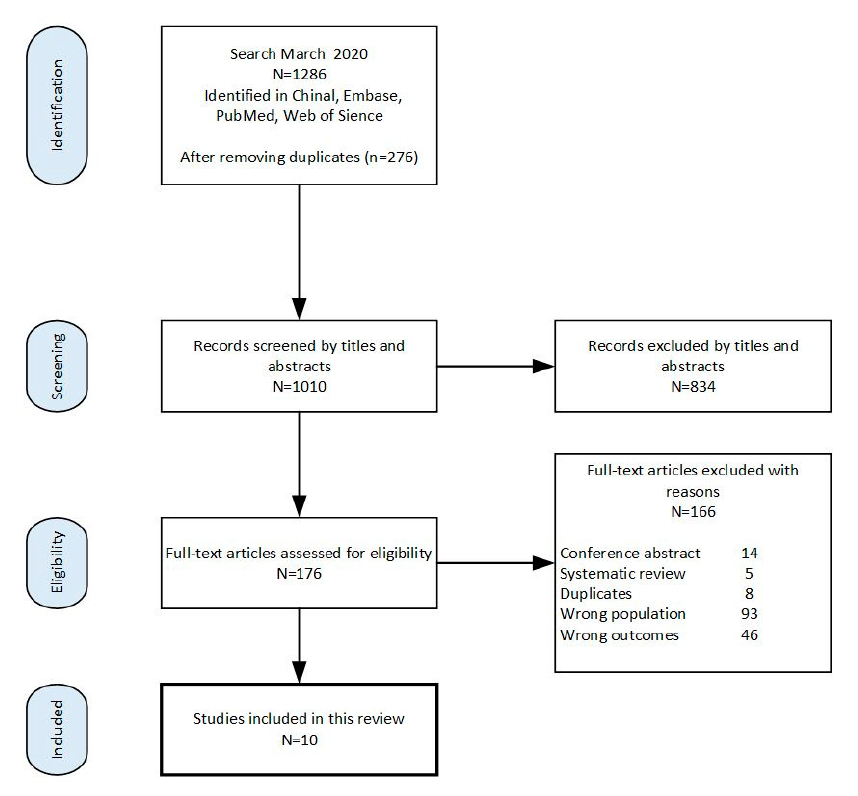
Figure 1. Flow diagram of the review process.